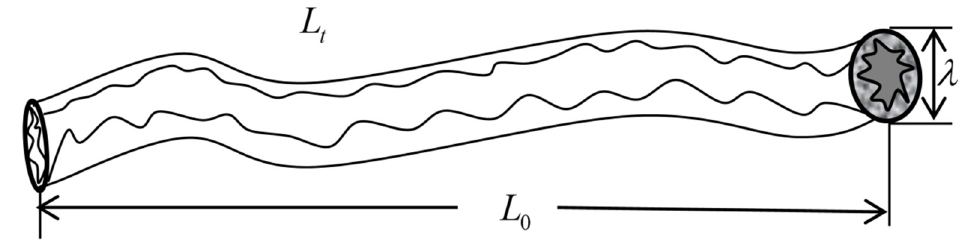
Figure 2. Model characterization of a single fracture.